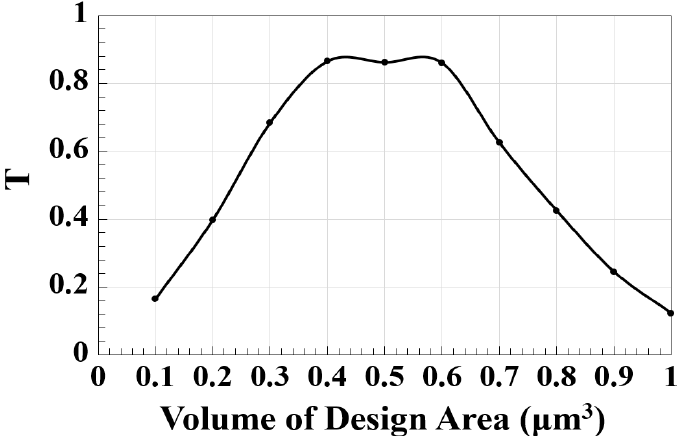
Figure 3. Spectral transmission (T) versus volume of design area utilizing 2 × 2 silicon waveguide at 1.55 μ m.